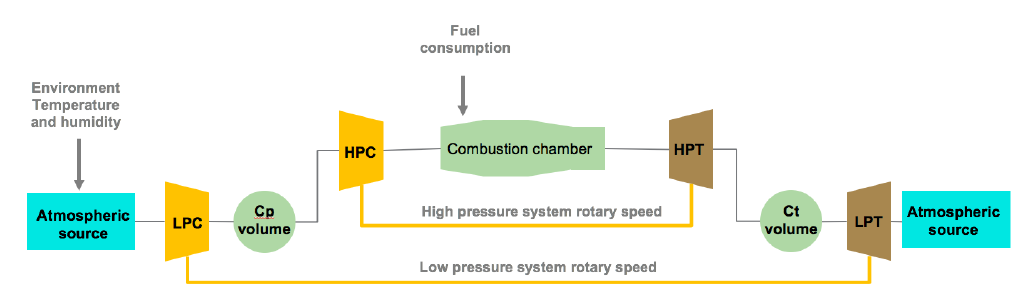
Figure 4. Architecture of the gas turbine